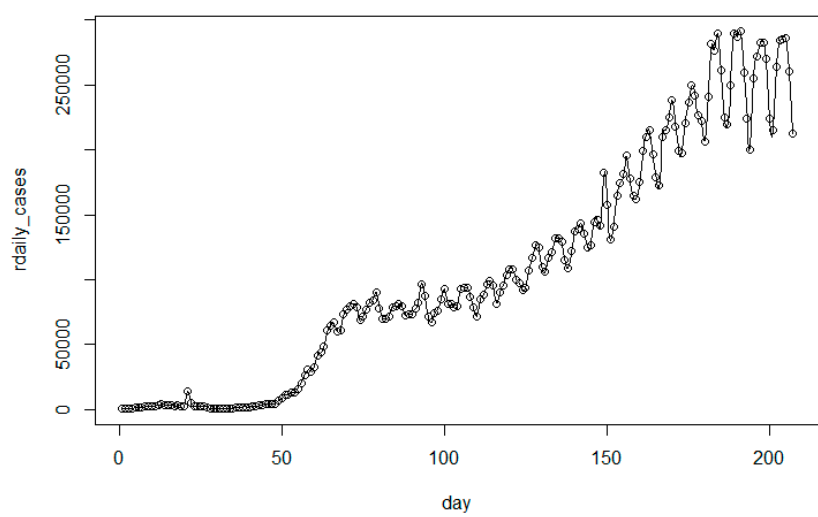
Figure 8. Worldwide daily number of infected cases over time. Table 3. Model comparison and ranking results using model selection criteria based on the available worldwide